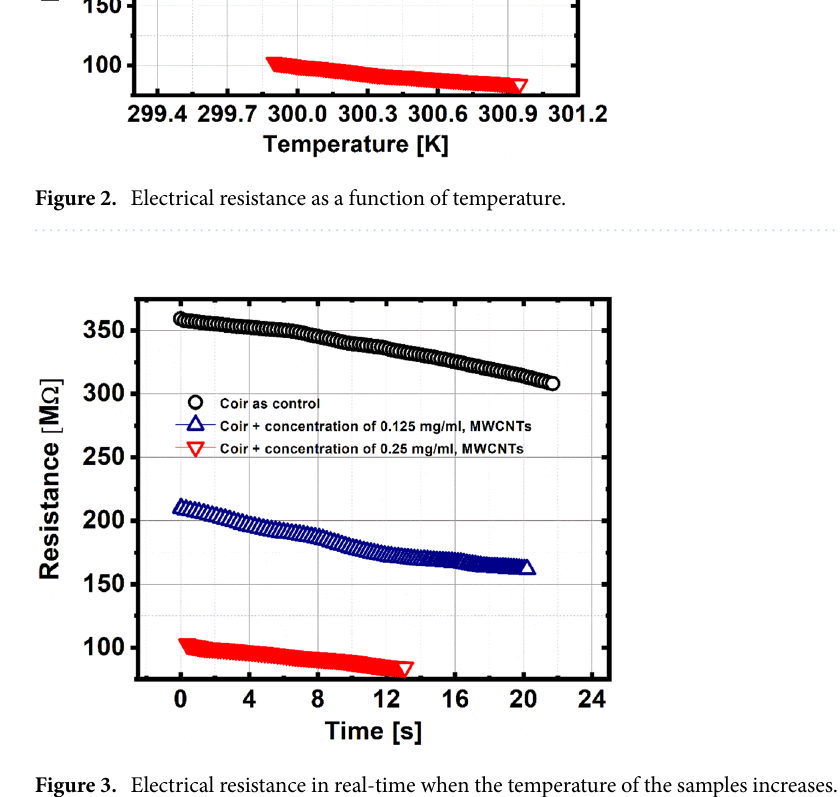
Figure 3. Electrical resistance in real-time when the temperature of the samples